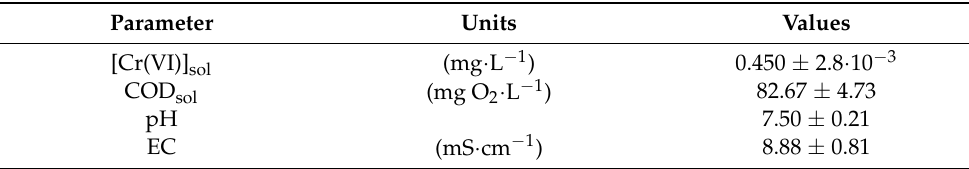
Table 2. Physical-chemical parameters of CCNC real